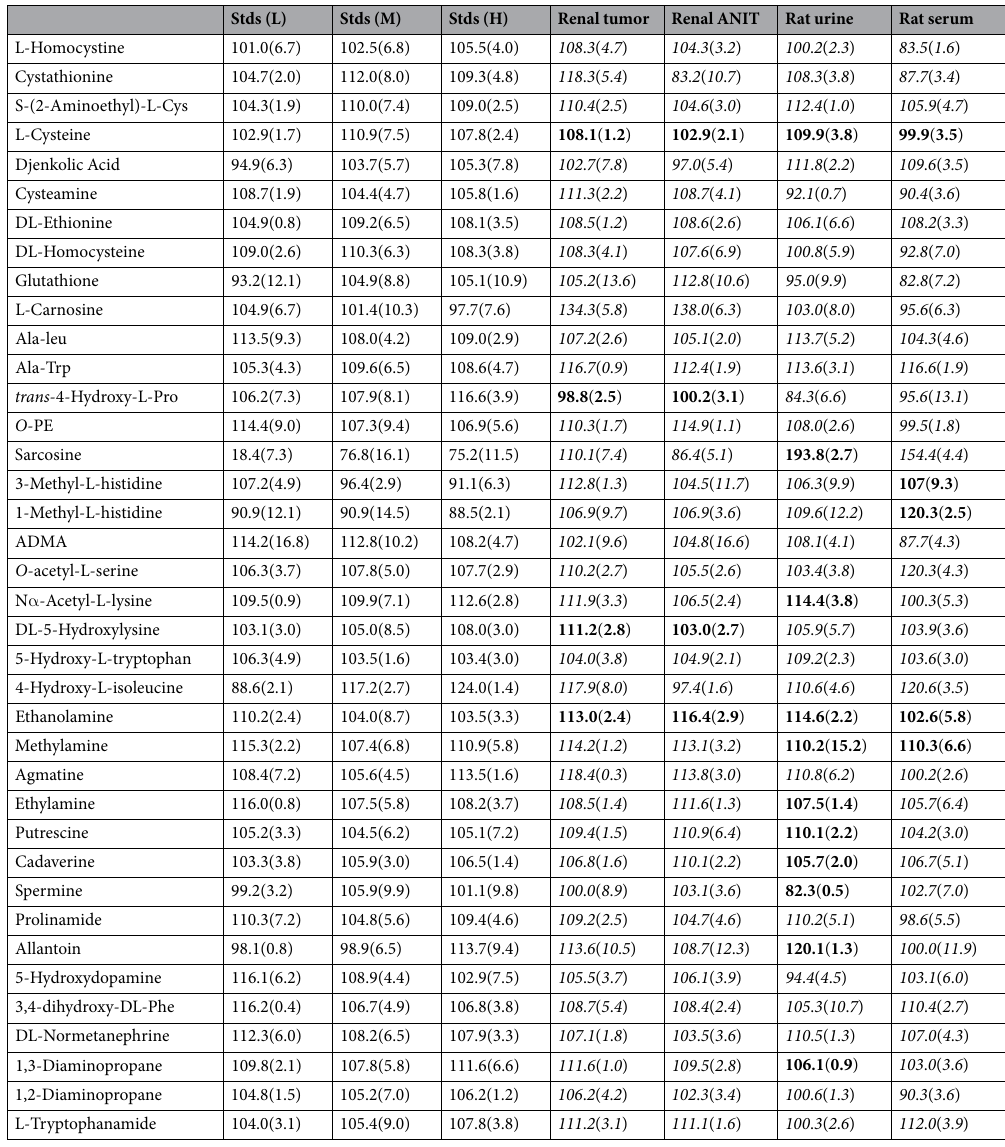
Table 2. Recoveries for 95 representative amino analytes with low (L), intermediate (M) and high concentration (H) from standard mixtures (Stds, n = 5), human renal tumor and adjacent non-involved tissues (ANIT) (n = 6), rat urine and serum (n = 6) samples. Data in parathesis are RSD (%); data in bold letters were from metabolites detected in real sample whereas these in italics were not. ADMA: Asymmetric dimethylarginine; Cys: cysteine, Pro: proline; O -PE: O -Phosphorylethanolamine; Phe: